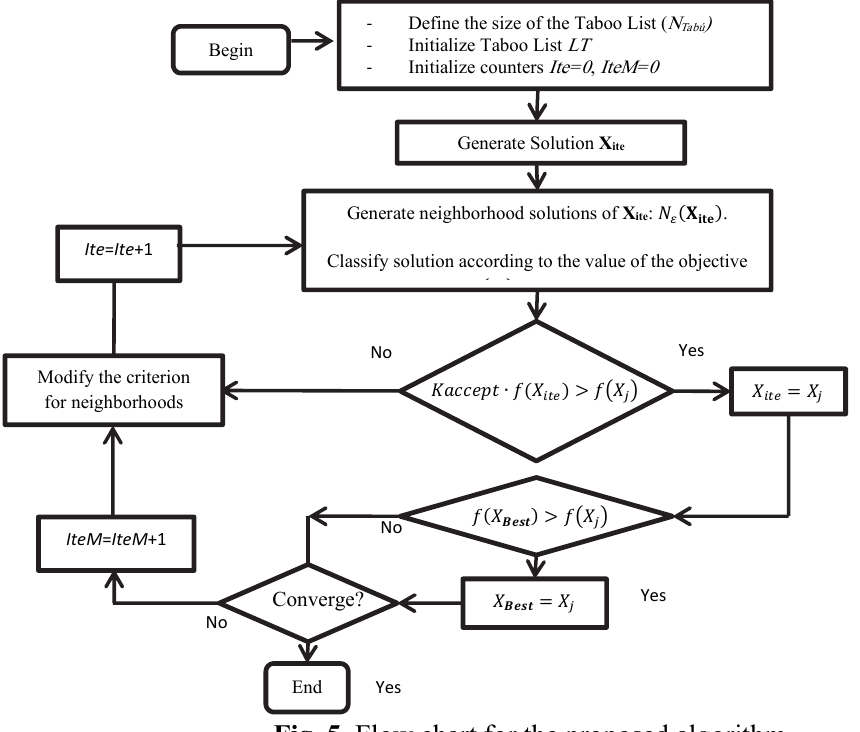
Fig. 5. Flow chart for the proposed